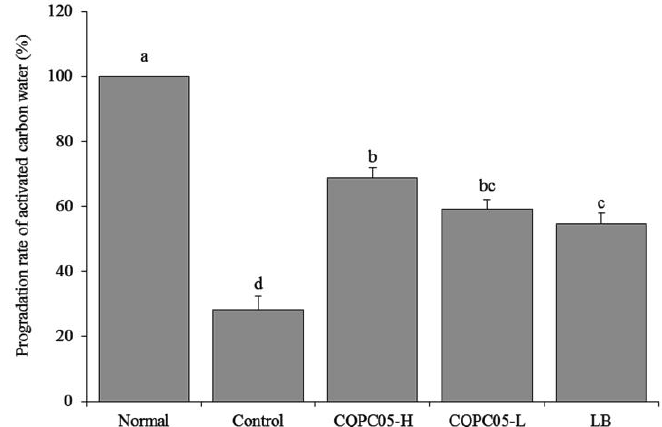
Figure 4. Average excretion times of the first tarry stool of the Lactobacillus plantarum CQPC05 and Lactobacillus delbrueckii subsp. bulgaricus treated activated carbon-induced constipation mice (average value of five mice in each group). a − d The different letters mean that there are significant differences ( p < 0.05) between every two groups according to Duncan’s multiple range test. LB: Lactobacillus delbrueckii subsp. bulgaricus (1.0 × 10 9 colony-forming unit (CFU)/kg body weight (bw)); CQPC05-L: Lactobacillus plantarum CQPC05 low dose (1.0 × 10 8 CFU/kg bw); CQPC05-H: Lactobacillus plantarum CQPC05 high dose (1.0 × 10 9 CFU/kg bw).